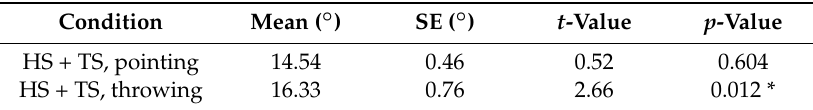
Table 1. Results and statistical comparison of the sum of unconscious head rotation (HS) plus total straight ahead/direct effect (TS), for pointing and throwing, after adaptive interval in a bright laboratory, before any feedback on hand position but with prisms on. Two-sided t -test against the prism’s optical power. Condition Mean ( ◦